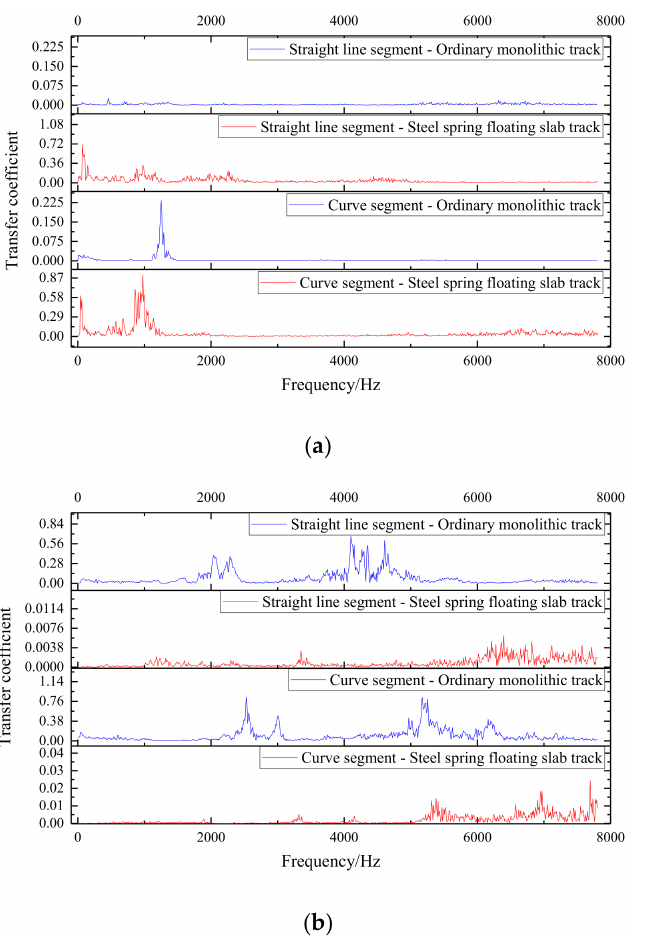
Figure 22. Comparison of transfer coefficients between track components. ( a ) Rail–track bed; ( b ) track bed–tunnel wall.